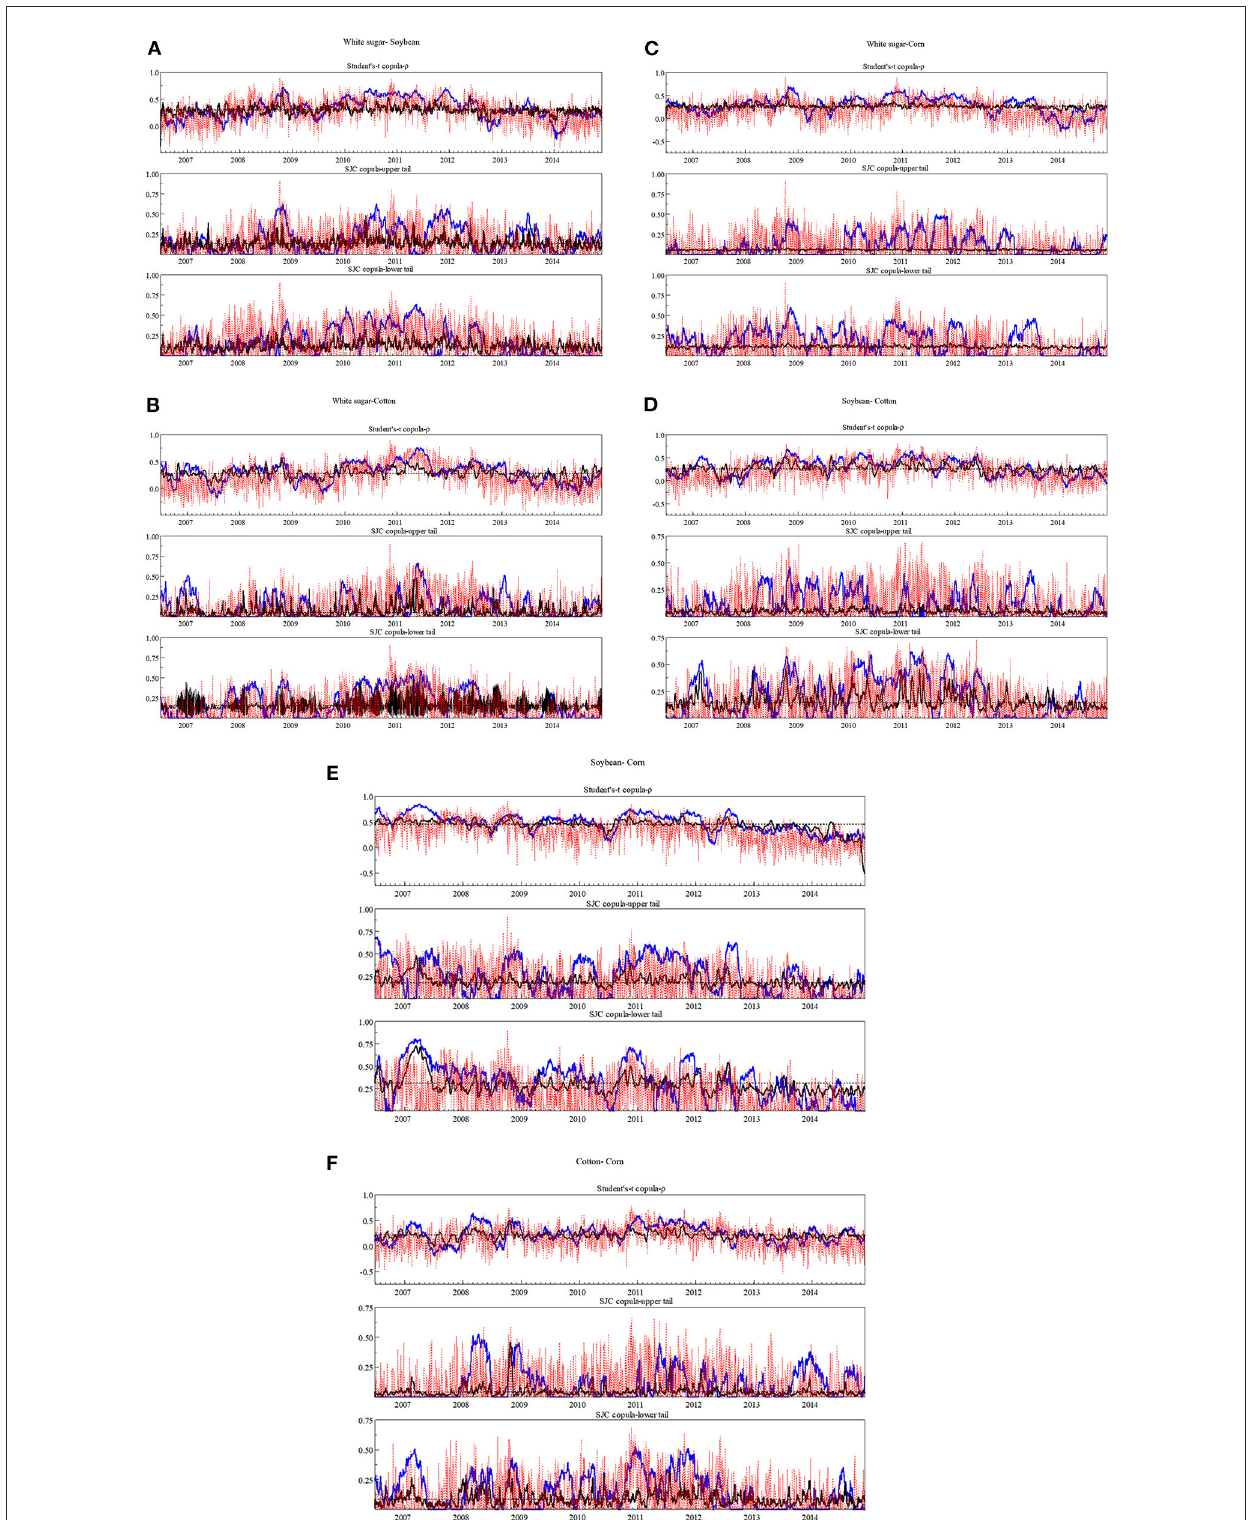
FIGURE5 Evolution of the estimated dependence of white sugar-soybean (A) , white sugar-cotton (B) , white sugar-corn (C) , soybean-cotton (D) , soybean-corn (E) , and cotton-corn (F) . Measure ρ for the Student’s- t copula and tail dependence measures τ U and τ L for the SJC copula with the constant unconditional dependence estimator (black dotted horizontal lines), intraday dependence estimator (red dotted lines), rolling window estimator (blue solid lines) and autoregressive estimator (black solid